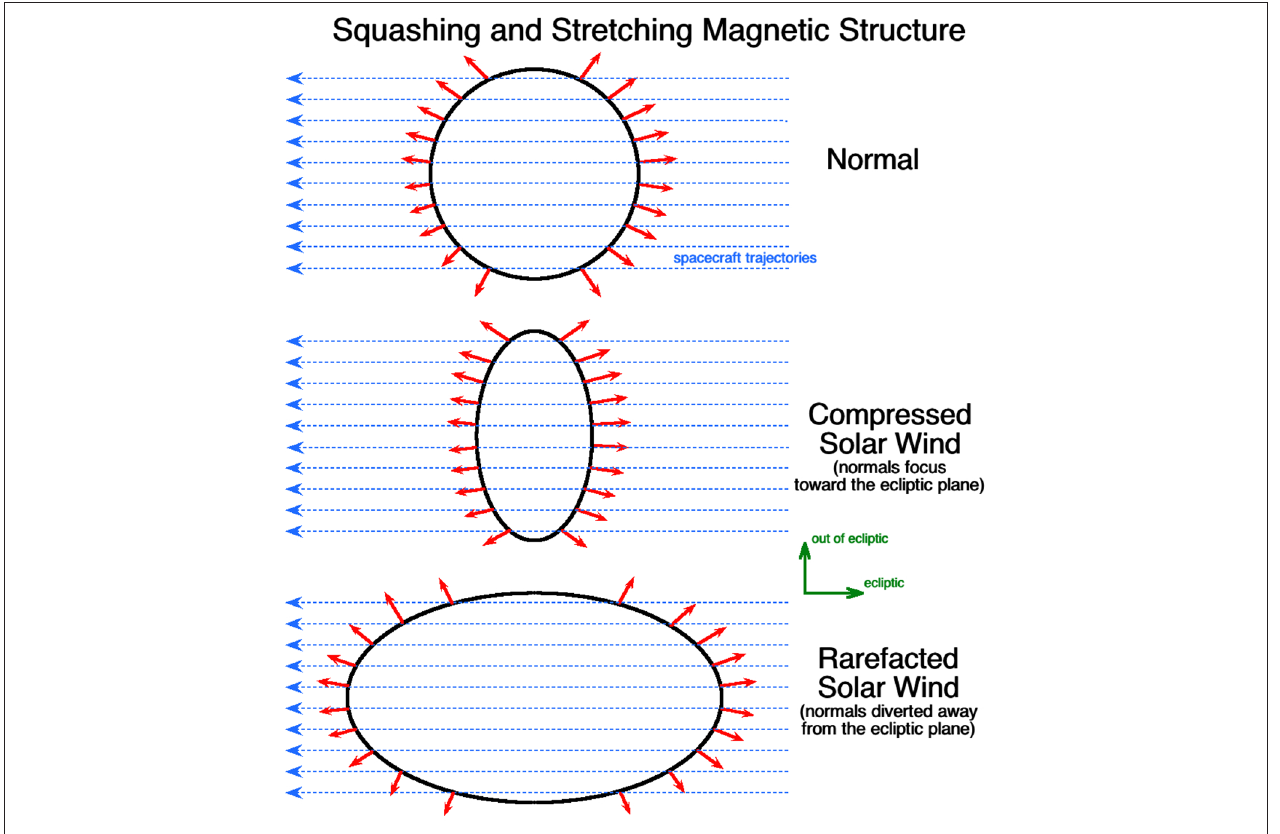
FIGURE 3 | The cross sections of three flux tubes are sketched: a round flux tube (Top) , a round flux tube that was compressed (Middle) , and a round flux tube that was rafefacted (Bottom) . The blue dashed curves are sample spacecraft trajectories through the flux tubes and the red arrows are normals to the flux-tube walls at the point where the spacecraft crosses the wall. The ecliptic plane and normal to the ecliptic plane are noted in green.